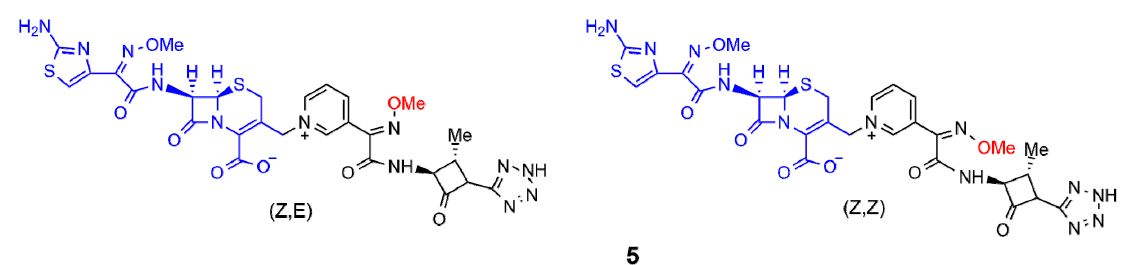
Figure 3. Selected β -lactam antibiotics synthesized by Panunzio et al. (ref. [15]). The moiety highlighted in blue is the portion derived from cefotaxime, the one in black is the aztreonam derivative. The methoxy-imine group mentioned in the text is reported in red.